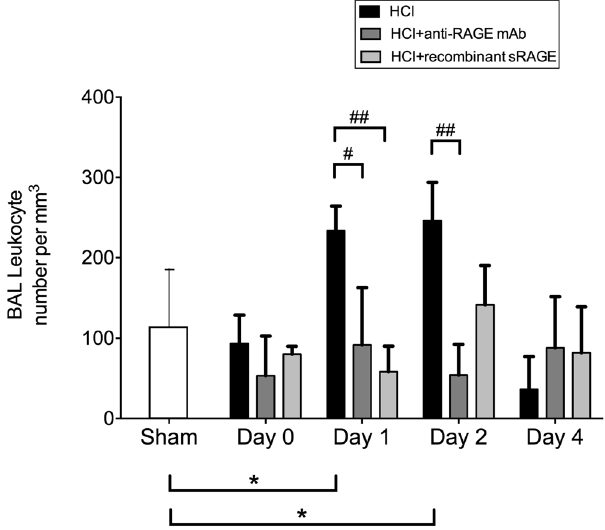
Figure 6. RAGE inhibition decreases the absolute number of leucocytes in the bronchoalveolar lavage (BAL). Total numbers of BAL leucocytes in uninjured, untreated mice (Sham group), acid-injured animals (HCl group) and acid-injured animals treated with sRAGE (HCl + recombinant sRAGE group) or with anti-RAGE monoclonal antibody (HCl + anti-RAGE mAb group) (n = 4–6 for each time-point). As no difference was observed between sham animals at all time points; the results from sham mice were mixed for analyses (left bar of the X-axis). Values are reported as means ± standard deviations. * P < 0.05 versus sham controls; # P < 0.05; ## P < 10 − 2 versus acid-injured